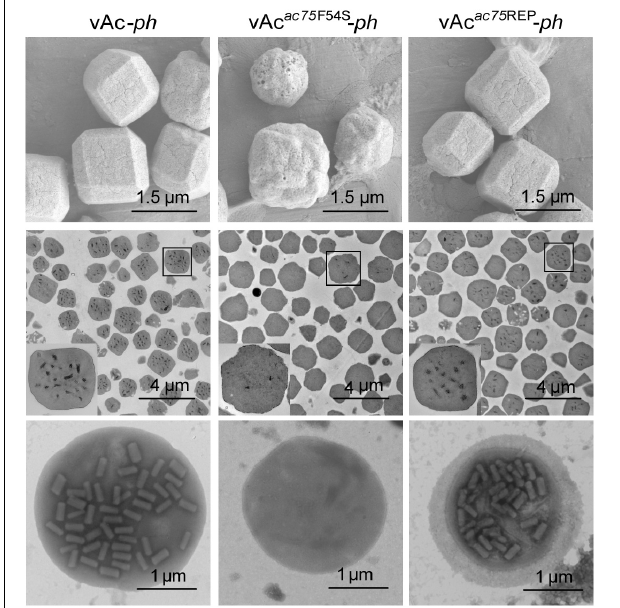
FIGURE 5 | SEM, TEM and negative staining analyses of OBs. The OBs were purified from S. exigua larvae infected with vAc- ph , vAc ac 75 F 54 S - ph or vAc ac 75REP - ph . (Upper panel) SEM analyses of OBs. The images show the external morphology of OBs. (Middle panel) TEM analyses of OBs. The ultrathin sections enabled visualization of the internal structure of OBs. Boxed regions of the OB are magnified and shown in the inset. (Lower panel) Negative staining analyses of